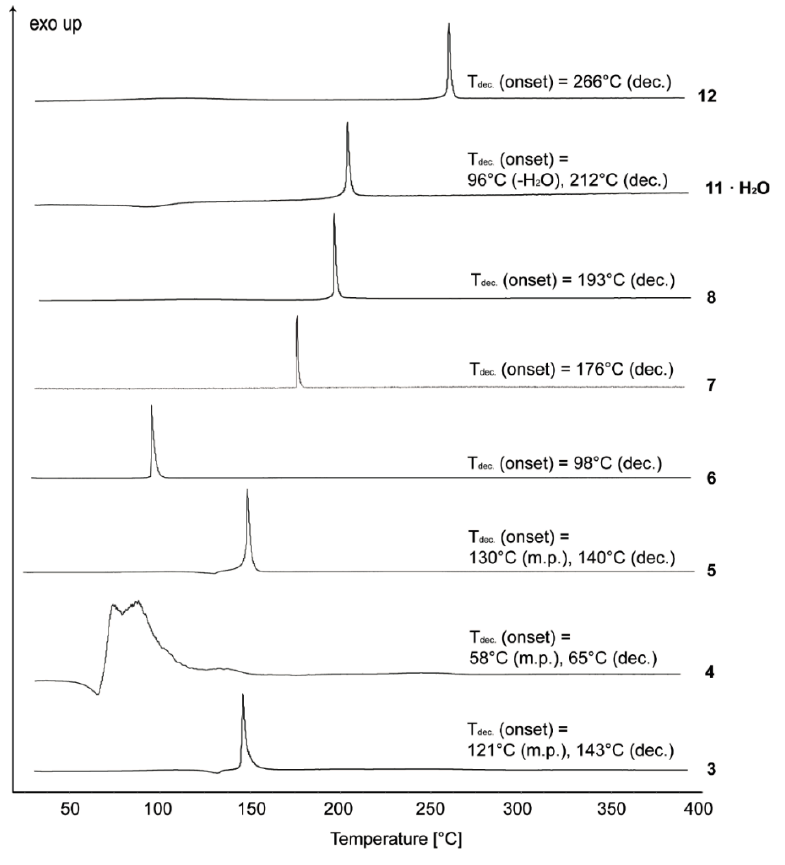
Figure 8. Differential thermal analysis (DTA) plots of compounds 3 – 12 measured with a heating rate of 5 °C·min − 1